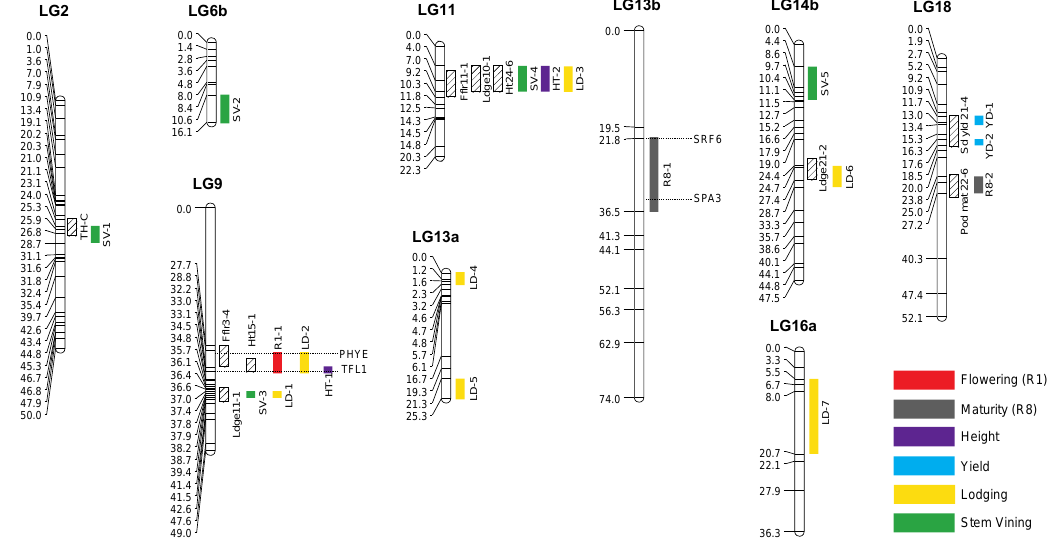
Figure 4. Quantitative trait loci (QTL) identified in this study. Nine linkage groups harbor QTL for